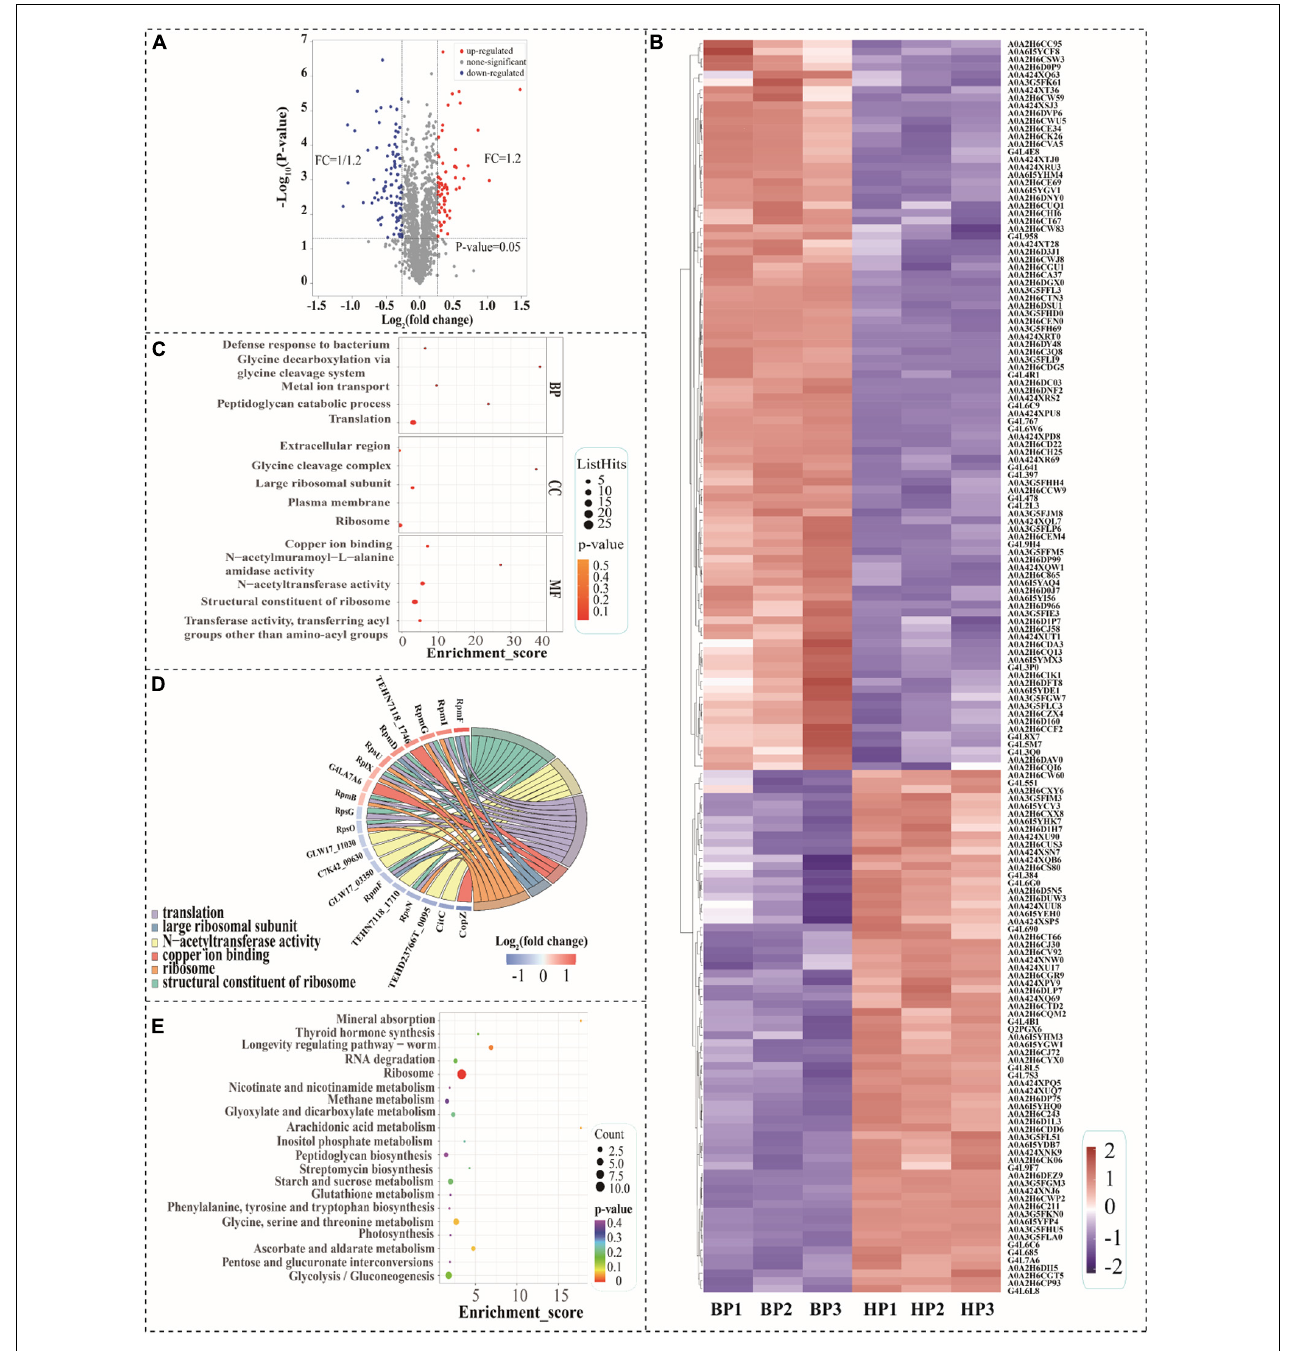
FIGURE 5 | Analysis of differentially expressed proteins (DEPs) at proteomic level. (A) Volcano diagram of the proteins after heat preadaptation; (B) Heat map of DEPs after heat preadaptation, BP1–BP3: before preadaptation, HP1–HP3: heat preadaptation; (C) The top 5 GO terms of three gene ontology categories, BP, biological process; CC, cellular component; MF, molecular function; (D) Chord chart for the DEPs after heat preadaptation; and (E) KEGG enrichment analysis of the top 20 pathways.